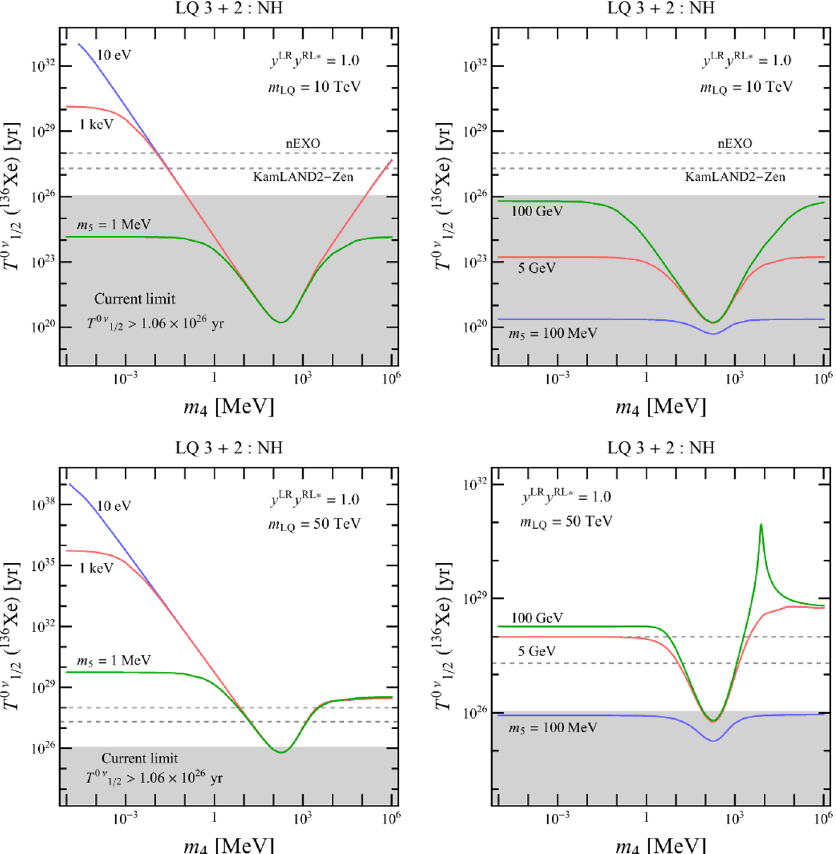
Figure 12 . Top-left panel: T 0 (cid:23) ( 136 Xe) as a function of m 4 in the LQ 3+2 leptoquark model for dif- 1 = 2 ferent choices of m 5 = 10 eV (blue), m 5 = 1 keV (red), m 5 = 1 MeV (green). We consider a leptoquark mass of 10 TeV. Top-right panel: same as top-left but now for m 5 = 100 MeV (blue), m 5 = 5 GeV (red), m 5 = 100 GeV (green). Bottom panels are the same as the top panels but now for a leptoquark mass of 50 TeV. All panels use the same phases, mixing angles, and LECs as in section